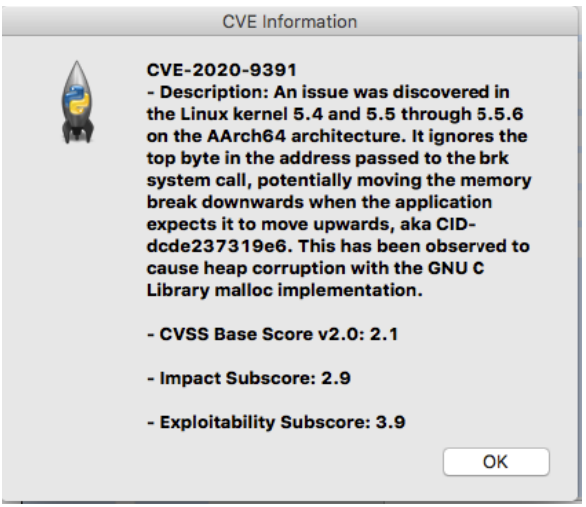
Figure 5. An example of CVE